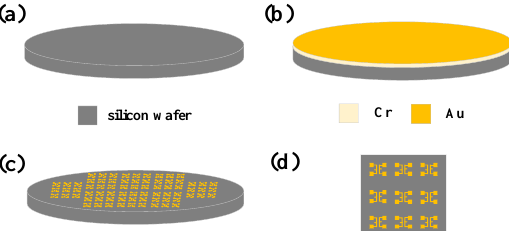
Figure 1. Process flow diagram for fabricating Cr/Au electrodes on silicon wafers. ( a ) Bare silicon pre-treatment. ( b ) Sputtering Cr/Au metal layer. ( c ) Acetone immersion peeling. ( d ) Dicing Silicon Crystals.